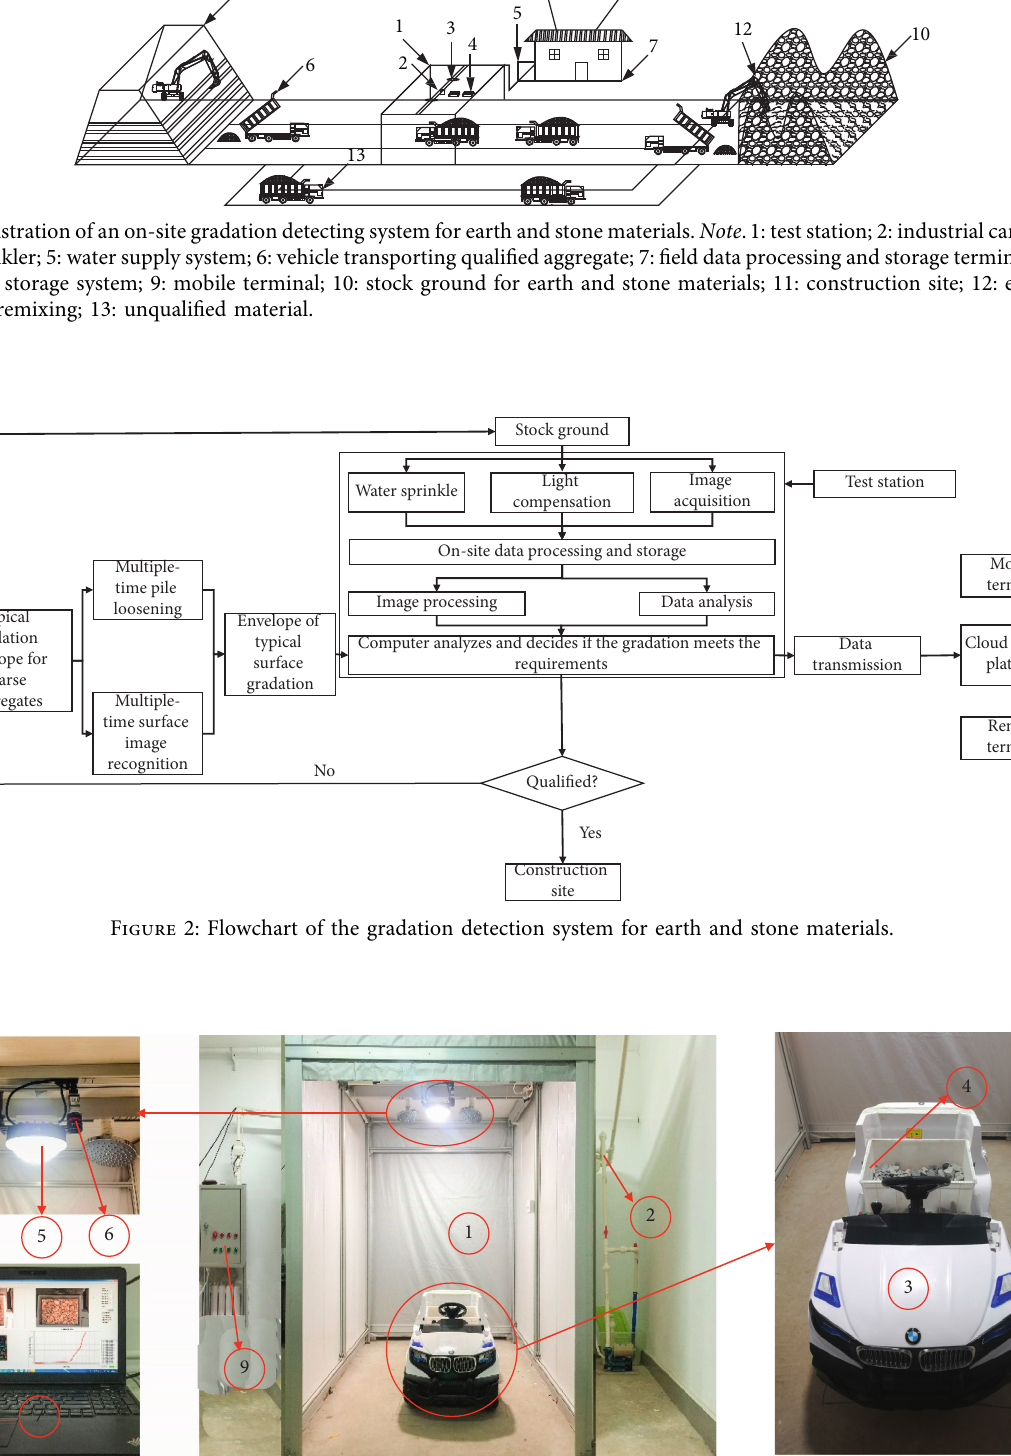
Figure 3: Prototype of the rapid gradation detection system for earth and stone